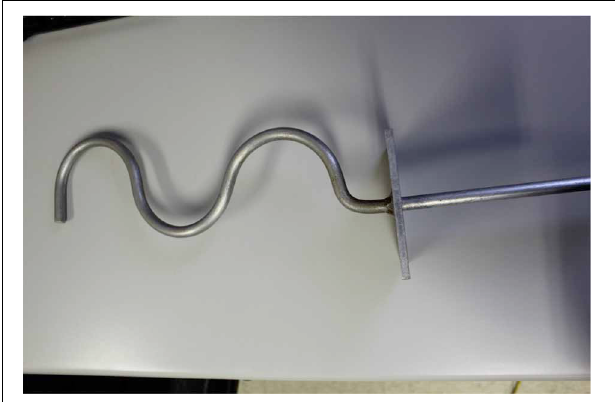
FIGURE 2 | Subject removing the nut from the curved metal rod with the target hand. Note that the non-target hand is grasping the stationing